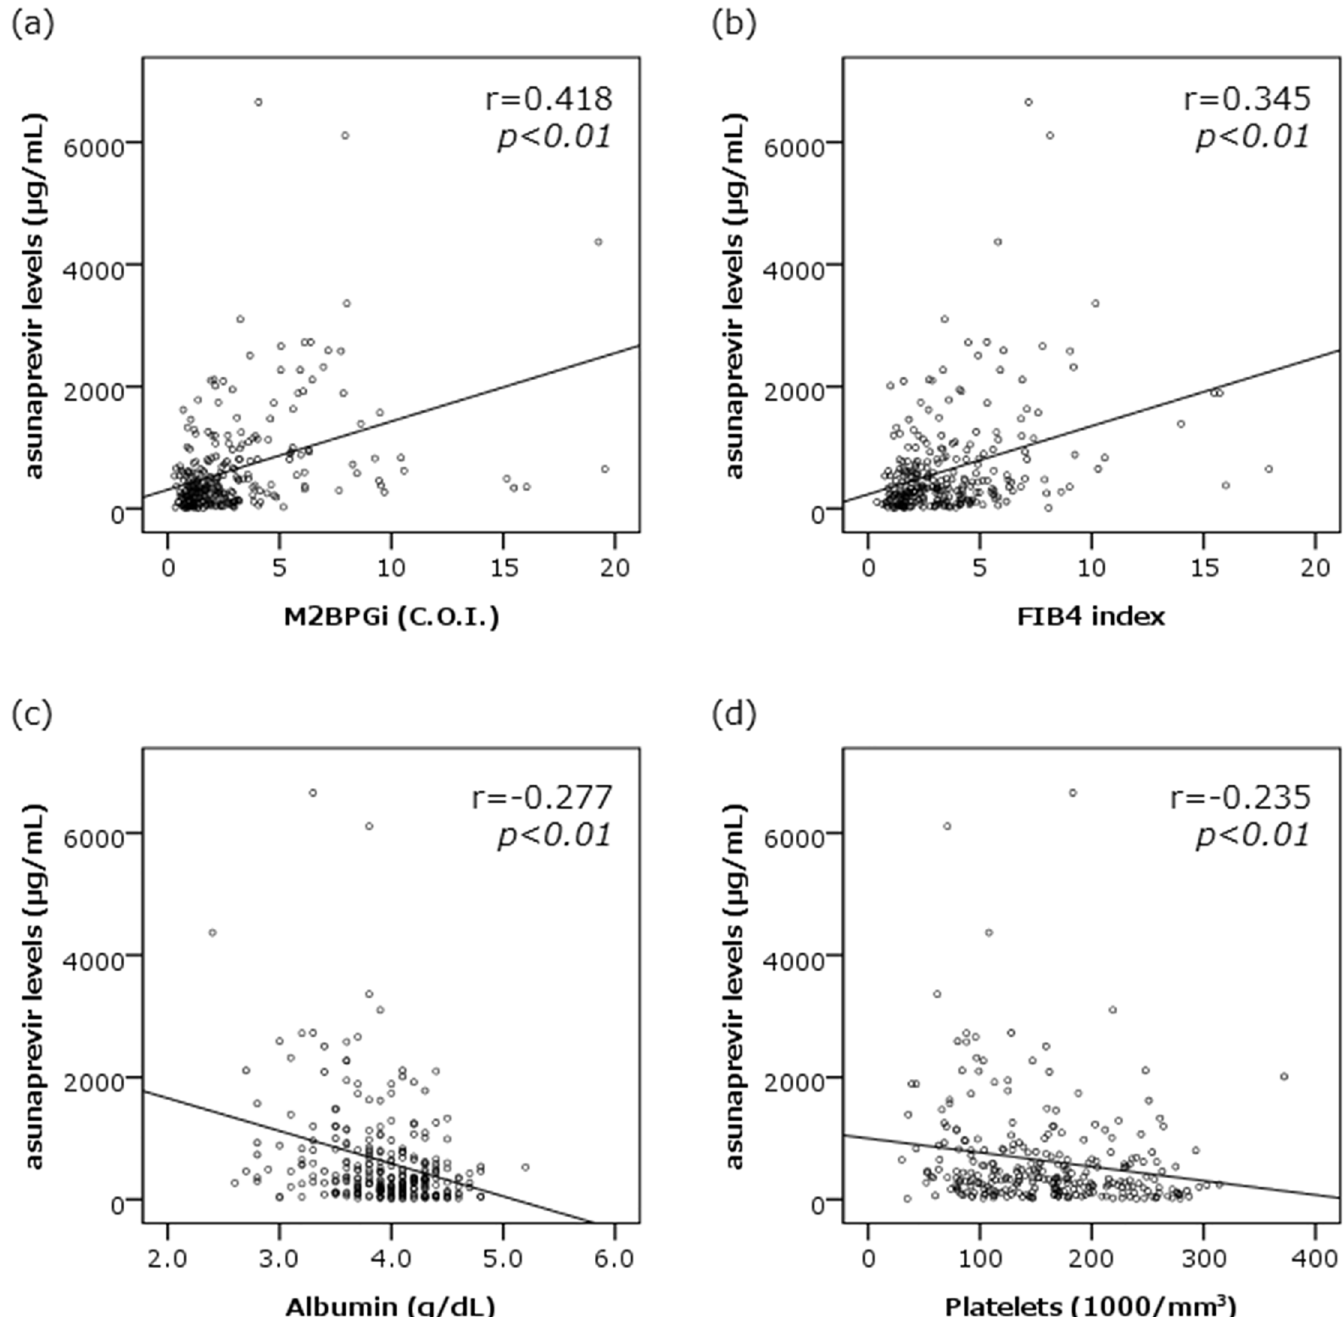
Fig 1. The scatter plots between serum concentrations of asunaprevir and either Mac-2 binding protein glycosylation isomer (M2BPGi) Levels, FIB4 index, serum albumin levels and peripheral platelet counts. Serum asunaprevir concentrations were positively correlated with serum M2BPGi levels (r = 0.418, p < 0.001) and FIB4 index (r = 0.345, p < 0.001) at 4 weeks after the initiation of DAV plus ASV therapy (a and b). Also, the concentrations were negatively correlated with serum albumin levels (r = -0.277, p < 0.001) and platelets counts (r = -0.235, p < 0.001) at baseline (c and